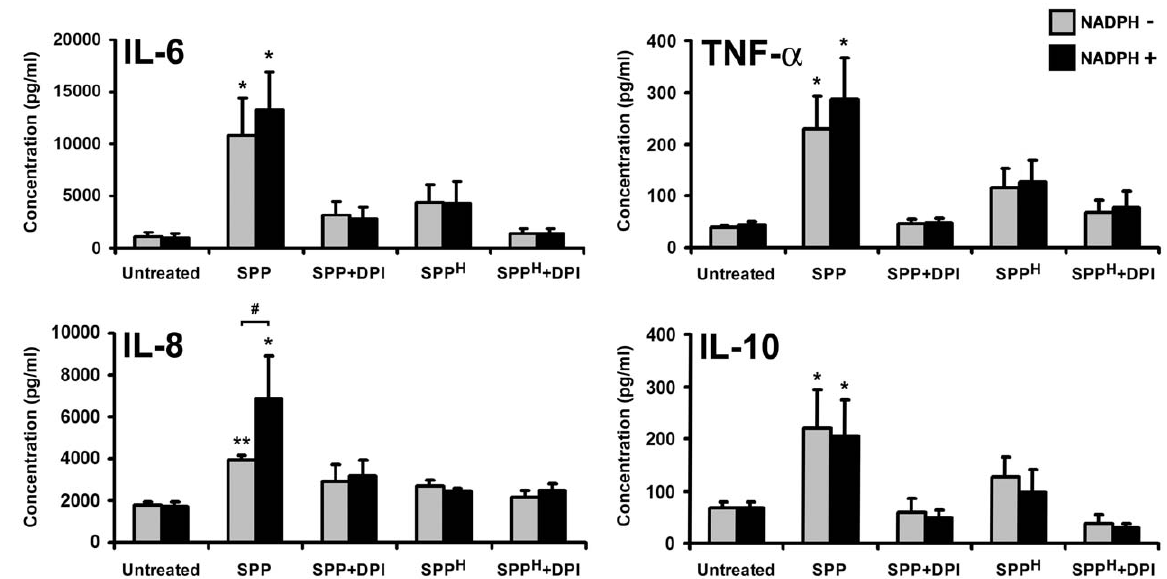
Figure 5. Cytokine and chemokine profile of human moDCs exposed to SPPs. ELISA was used to determine the release of cytokines (IL-6, TNF- a , IL-10) and chemokine (IL-8) from human moDCs in response to freshly isolated SPPs, DPI-treated SPPs, and heat-inactivated SPPs, in the presence and absence of NADPH, after 24 h incubation. Data are presented as means 6 SEM of four individual experiments. * p , 0.05; ** p , 0.01 vs untreated DCs, # p , 0.05. (DPI: diphenyleneiodonium; SPP: subpollen particle; SPP H : heat-inactivated SPP).